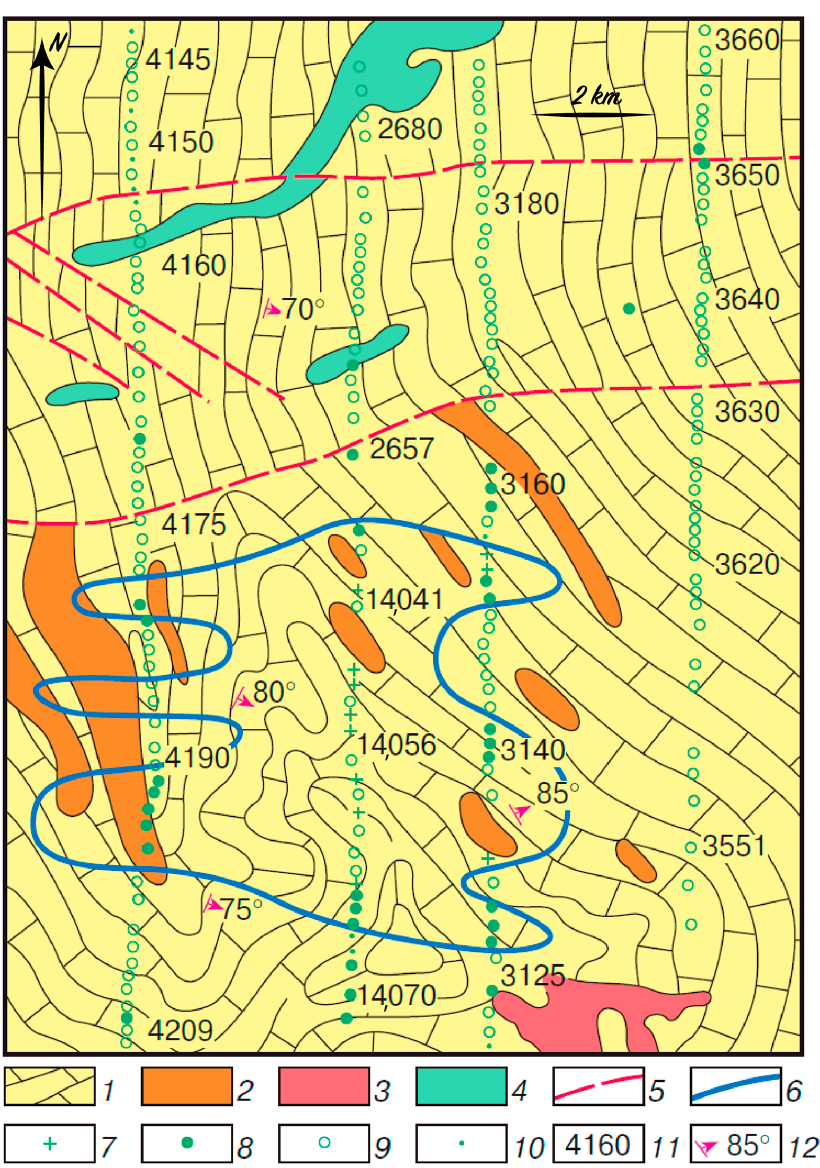
Figure 4. “Negative” biogeochemical Mo anomaly over the Telmanskoe Pb–Zn deposit. Symbols: 1—limestones; 2—ores and ore-hosting dolomites; 3—granites; 4—diabase porphyrites; 5—disjunctive faults; 6—outlines of anomalies; 7–10—sampling sites and Mo content (%) (7, below 5 × 10 − 4 ; 8, 5 × 10 − 4 ; 9, n × 10 − 3 ; 10, n × 10 − 2 ); 11—sample numbers; 12—dip and strike of rock layers.